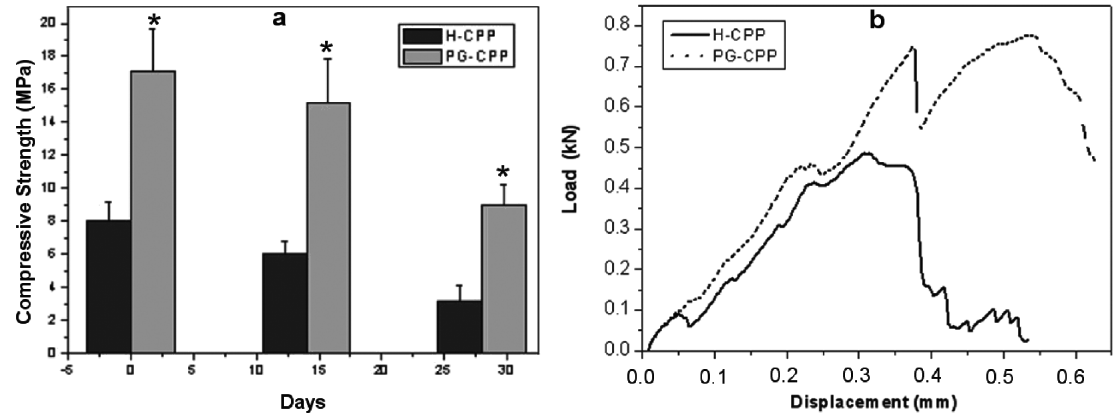
Fig. 3 – The mechanical property of H - CPP and PG - CPP: (a) compressive strength of both types of scaffolds before and after degradation. Asterisk (*) means that the compressive strength of PG - CPP has a statistically significant difference compared with the H - CPP, P < 0.05, n = 5; (b) the load-displacement curves of both types of